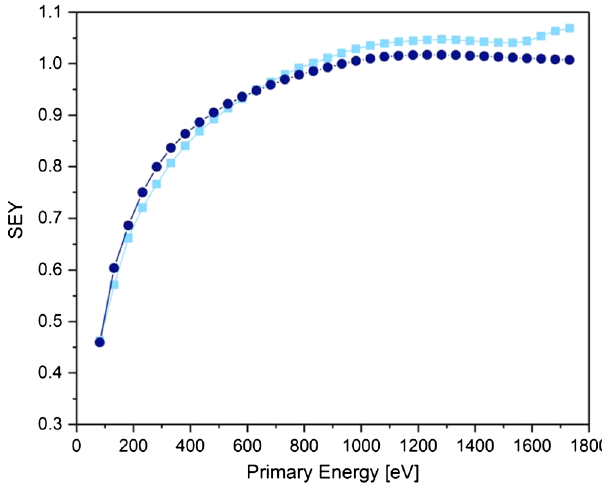
FIG. 9. SEYof samples from ASTeC treated at 90 mm = s (dark blue circles) and 120 mm = s (light blue squares) with LH pattern.